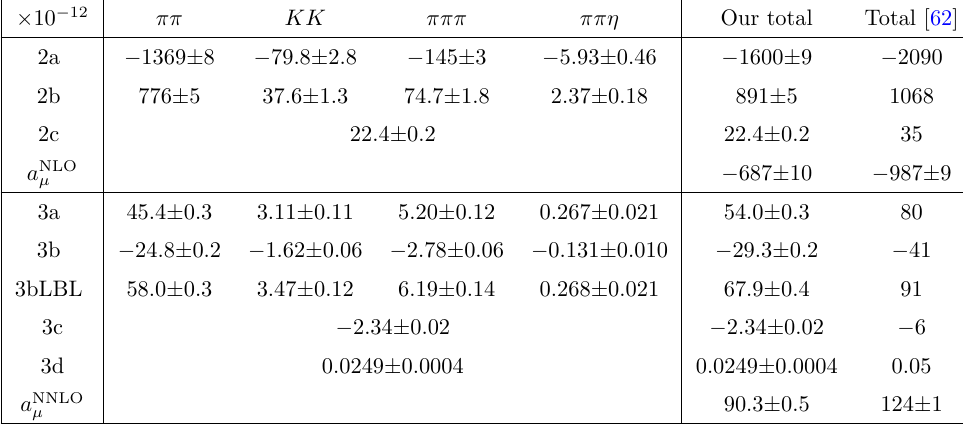
Table 4 . Our estimation of the higher-order HVP contributions to a had